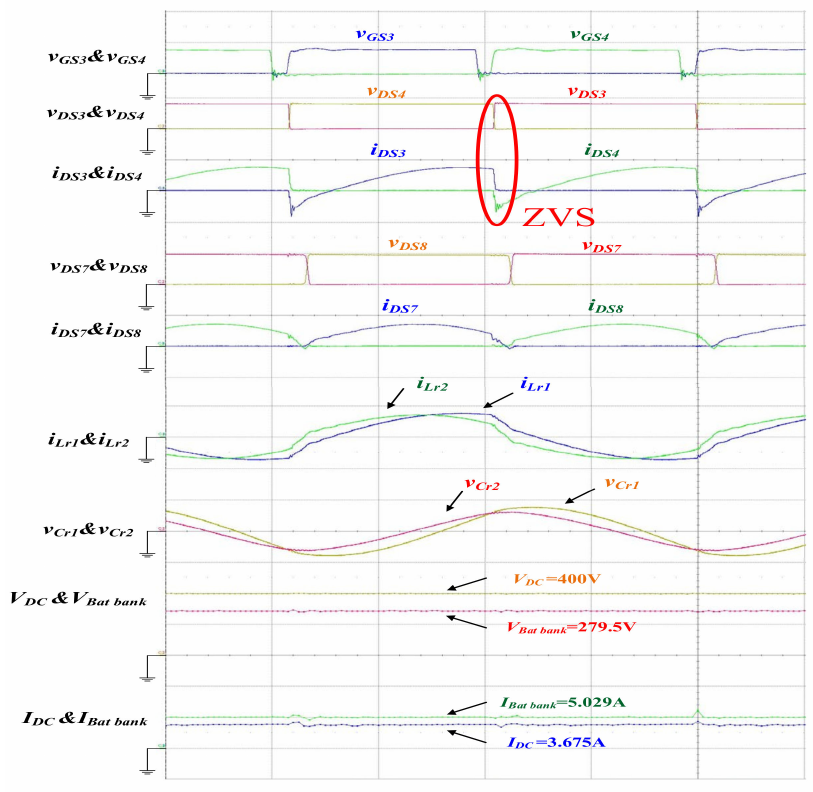
Figure 16. Waveforms obtained when the output battery voltage, V Bat bank , was 280 V and the fabricated converter was operated at full load ( v GS 3&4 : 20 V/div, v Cr 1&2 , and V DC ; V Bat bank : 200 V/div; v DS 7&8 : 300 V/div; v DS 3&4 : 500 V/div; i DS 3&4 , i Lr 1&2 , i DS 7&8 : 10 A/div; I Bat bank , I DC : 5